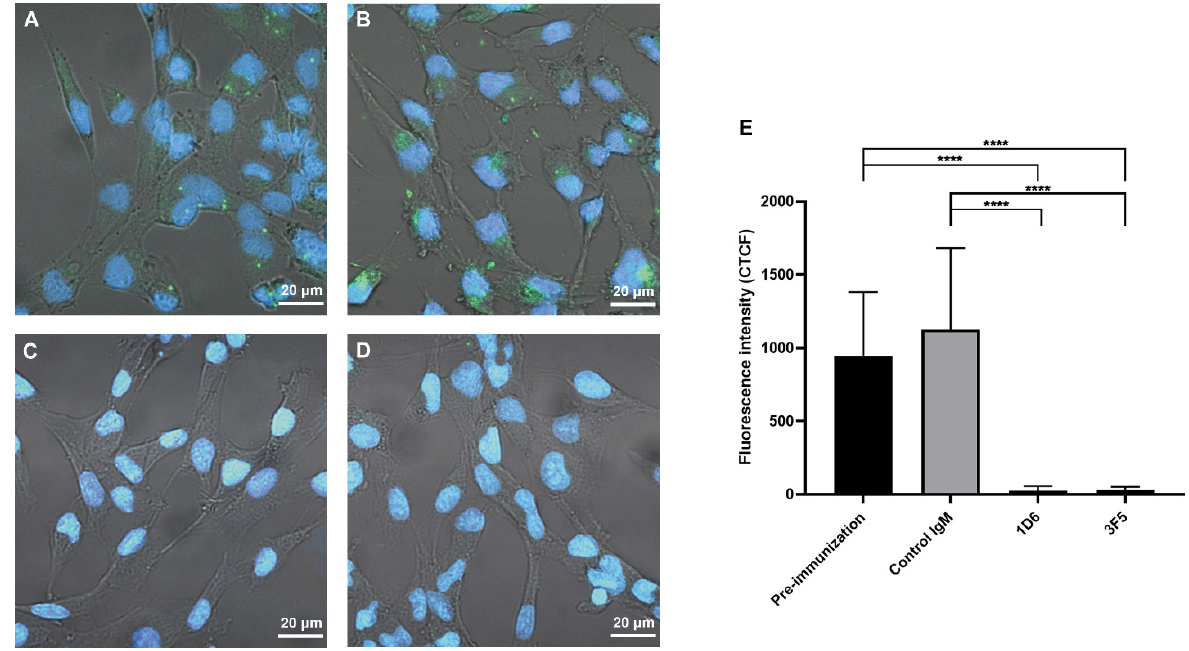
Figure 5. Anti- Ov -TSP-2-LEL mAbs (1D6 and 3F5) block Opisthorchis viverrini EV internalization by the H69 human cholangiocyte cell line. A total of 1.25 µ g (5 × 10 7 vesicles) of PKH67-labeled O. viverrini extracellular vesicles were incubated with ( A ) hamster pooled pre-vaccination serum (at a dilution of 1:2.5) and incubated with a 1.25 µ g of the three mAbs including ( B ) mouse IgM isotype control mAb, ( C ) anti- Ov -TSP-2-LEL mAbs 1D6, and ( D ) anti- Ov -TSP-2-LEL mAbs 3F5, before co-culture with H69 cholangiocytes (15,000 cells per well) for 2 h. ( E ) Corrected total cell fluorescence (CTCF) at 490 nm (green channel) was quantified using ImageJ software. The nuclei were stained blue using Hoechst dye no. 33258. Bars indicate standard deviation of the mean. **** p < 0.0001.